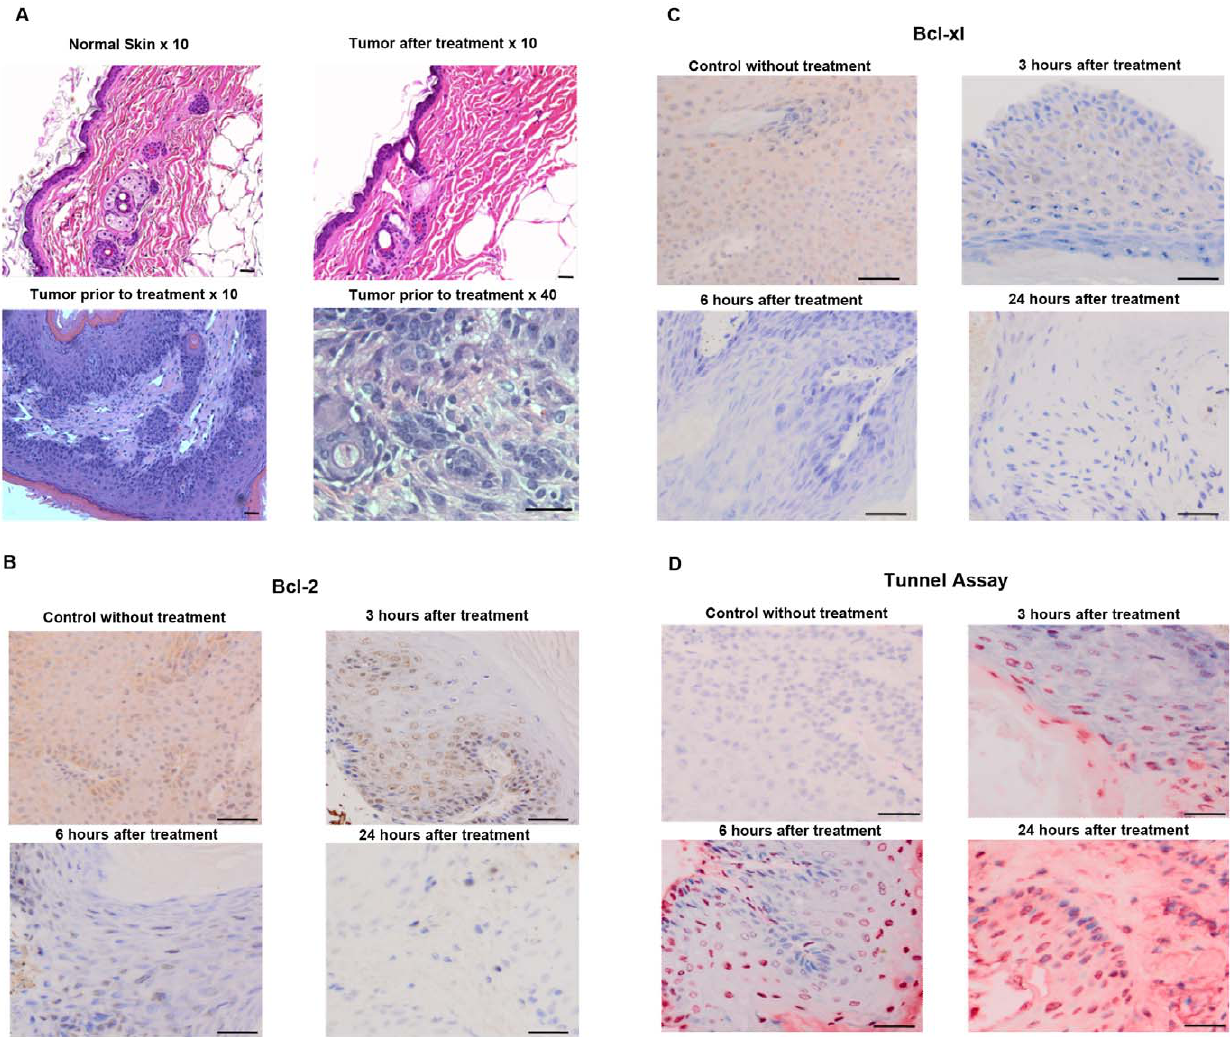
Figure 5. Histology and immunohistochemistry examination. Histopathology (Hematoxylin and Eosin stain) of unaffected normal mouse skin and induced papillomas and squamous cell carcinomas (prior to nsPEF exposure and 5 weeks following effective exposure to 200 pulses of 14 ns duration, 50 Hz, 40 kV/cm) (Panel A ). Carcinogen induced tumors were treated with nsPEF (40 kV/cm, 50 Hz, 1.75 mm tip 200p). After 3, 6 and 24 hours, immunohistochemistry was performed to detect the anti-apoptotic proteins Bcl-2 (brown in Panel B) and Bcl-xl (brown in Panel C), as well as, apoptosis as shown by TUNEL assay (Terminal deoxynucleotidyl transferase dUTP nick end labeling) (red in Panel D). Scale bar: 50 m m.